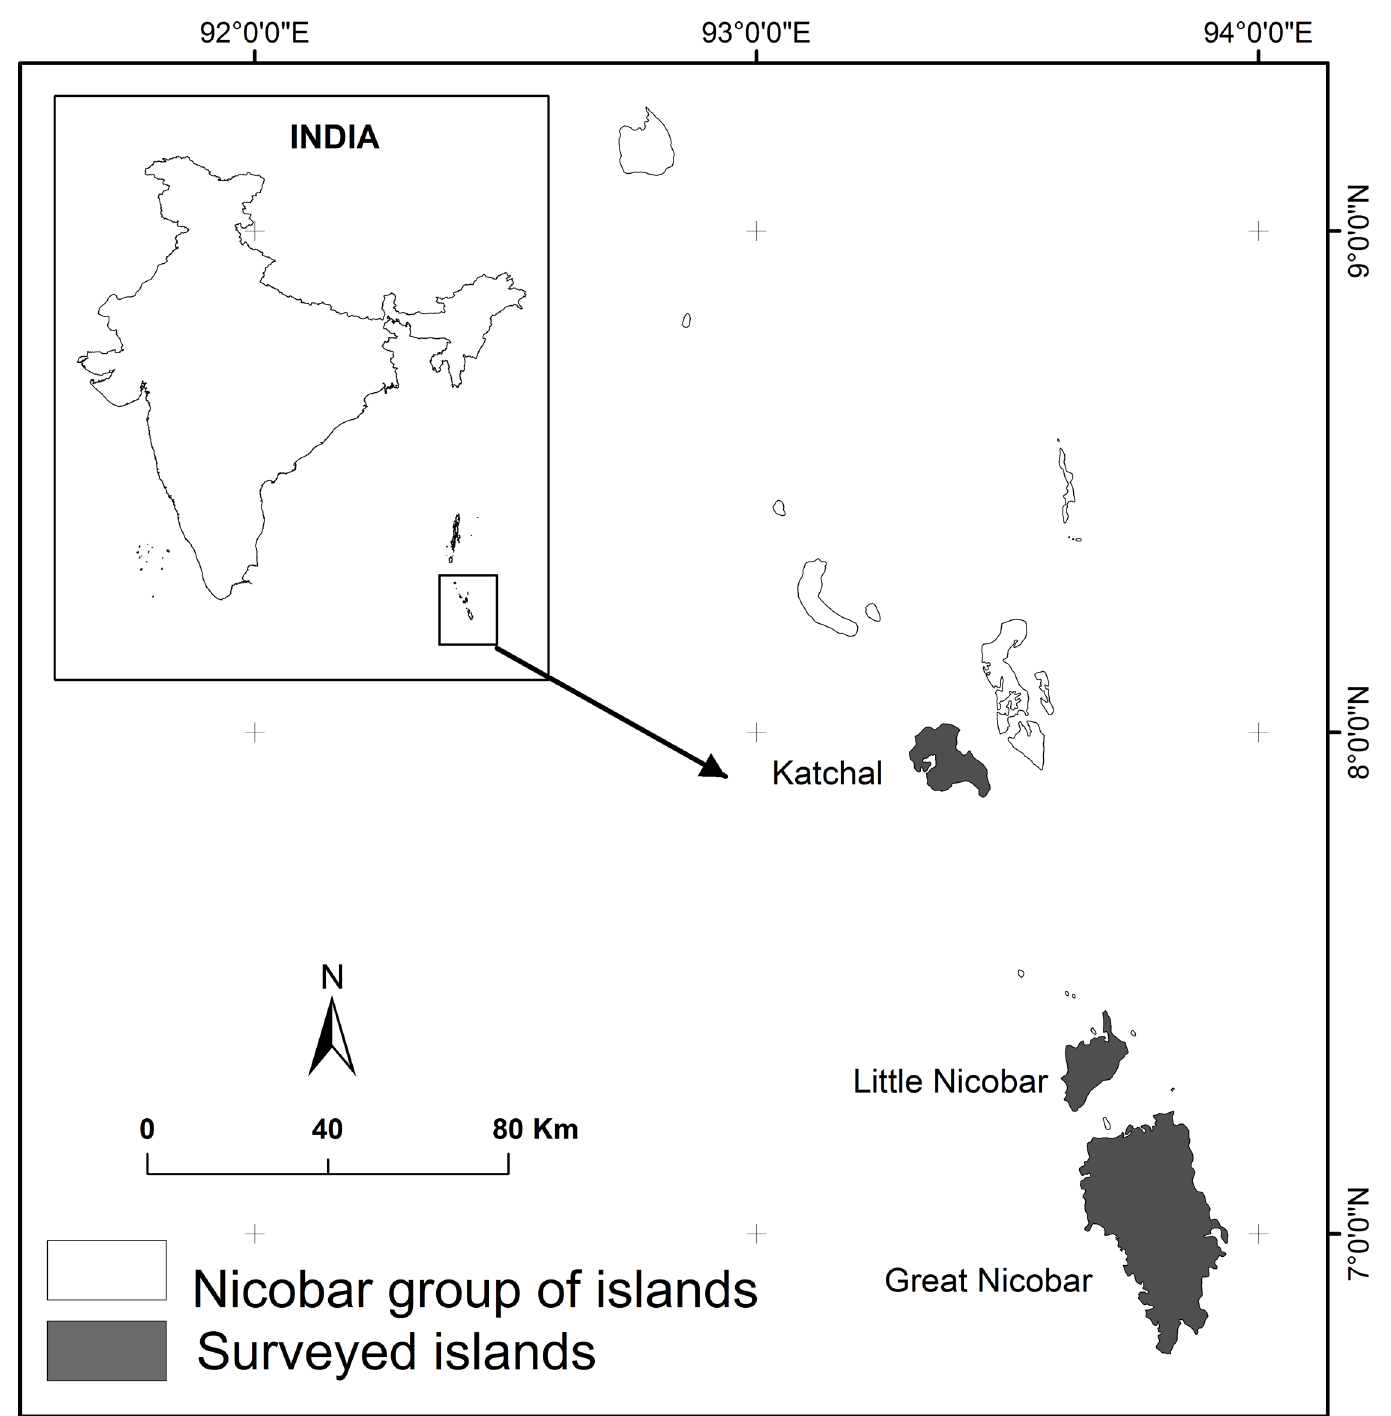
Fig 1. Map of study sites in Nicobar group of